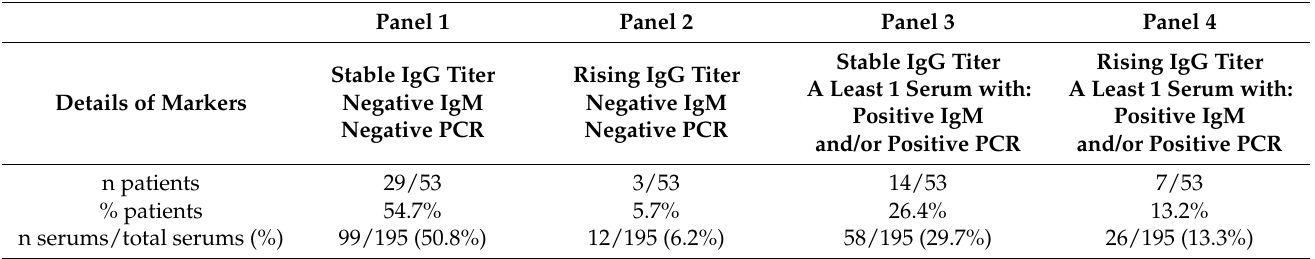
Table 1. Distribution of serological and molecular profiles of the 53 pregnant women with CMV non-primary infection (195 serum samples, distributed according to the panel: none, one, two or three markers).